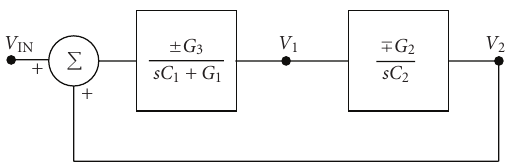
Figure 1: Block diagram of the two integrator loop